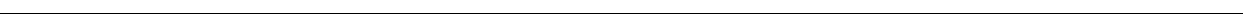
Fig. 5 Additional validations of GCaMP-X. a Nuclear accumulation was substantially relieved for cortical neurons transfected with GCaMP-X. N/C fl uorescence ratios indicative of GCaMP distributions in cortical neurons (DIV 5) were quanti fi ed 2 days after being transfected with GCaMP3, GCaMP3- X O or GCaMP3-X C . b GCaMP-X sensors no longer perturbed pCREB signals. For cortical neurons transfected with YFP, GCaMP3-X O or GCaMP3-X C , fl uorescence of pCREB immunostaining (left) was normalized and compared (right). Dotted lines represent the mean values from nuclear-excluded GCaMP3 (pink) or nuclear- fi lled GCaMP3 (cyan) neurons, respectively (adopted from Fig. 3c). c Dysregulations of neurite outgrowth were diminished with GCaMP-X. Based on neurite tracing images (left), Sholl analysis (middle) and measurement of neurite length (right) were performed for cortical neurons transfected with YFP, GCaMP3-X O or GCaMP3-X C . Similar to b , dotted lines depict mean values of neurite length for nuclear-excluded GCaMP3 (pink) or nuclear- fi lled GCaMP3 (cyan) neurons (adopted from Fig. 1h). d Problematic nuclear accumulations were strongly attenuated for long-term viral expression of GCaMP6m-X C . Fluorescence indicative of sensor localization was mostly restricted to the cytosol of neurons infected with AAV- Syn -GCaMP6m-X C (GCaMP6-X C ), as shown by representative images at different time points (upper panel). The temporal trend of N/C ratio for GCaMP6-X C (red) is distinct from that for GCaMP6f (black, GCaMP6 data adopted from Fig. 1b). e Apoptotic damages arising from GCaMP were strongly attenuated in GCaMP-X